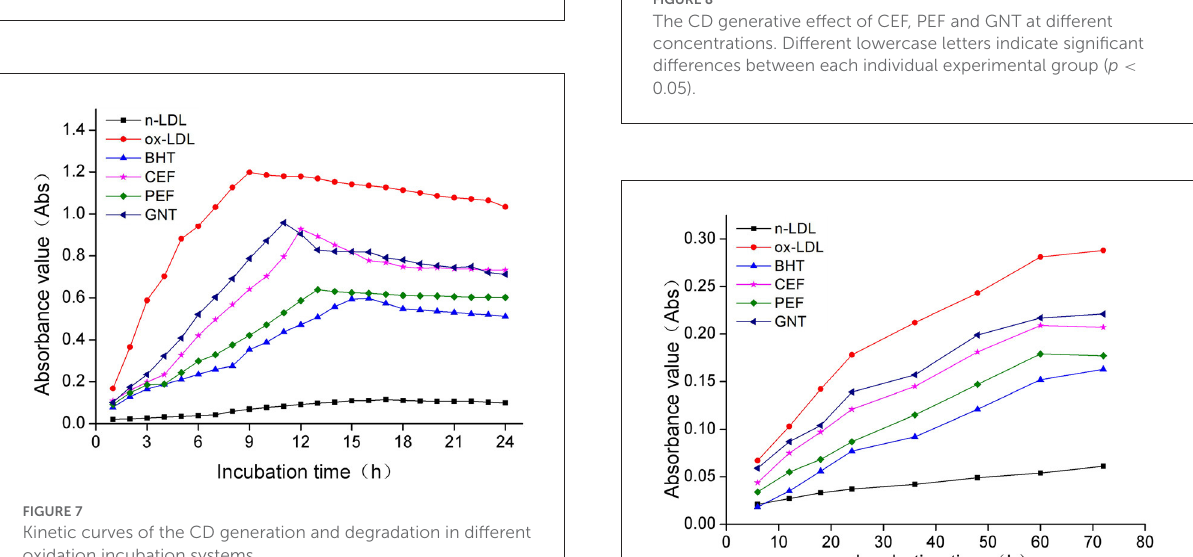
FIGURE6 Sodium dodecyl sulfate—LDL polyacrylamide gel electrophoresis. Lane: 1, Prestained Protein Ladder; 2–6, LDL diluted to 1, 5, 10, 20, 30 times; 7, plasma.